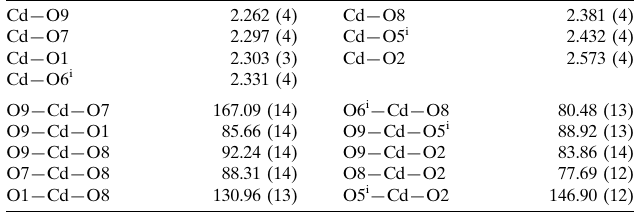
one-dimensional coordination polymer,